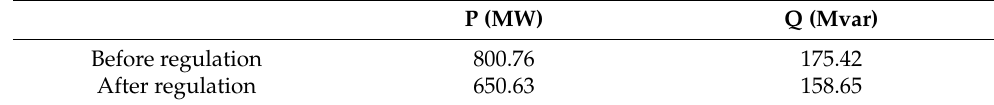
Table 7. Branch current of lines 15–16.